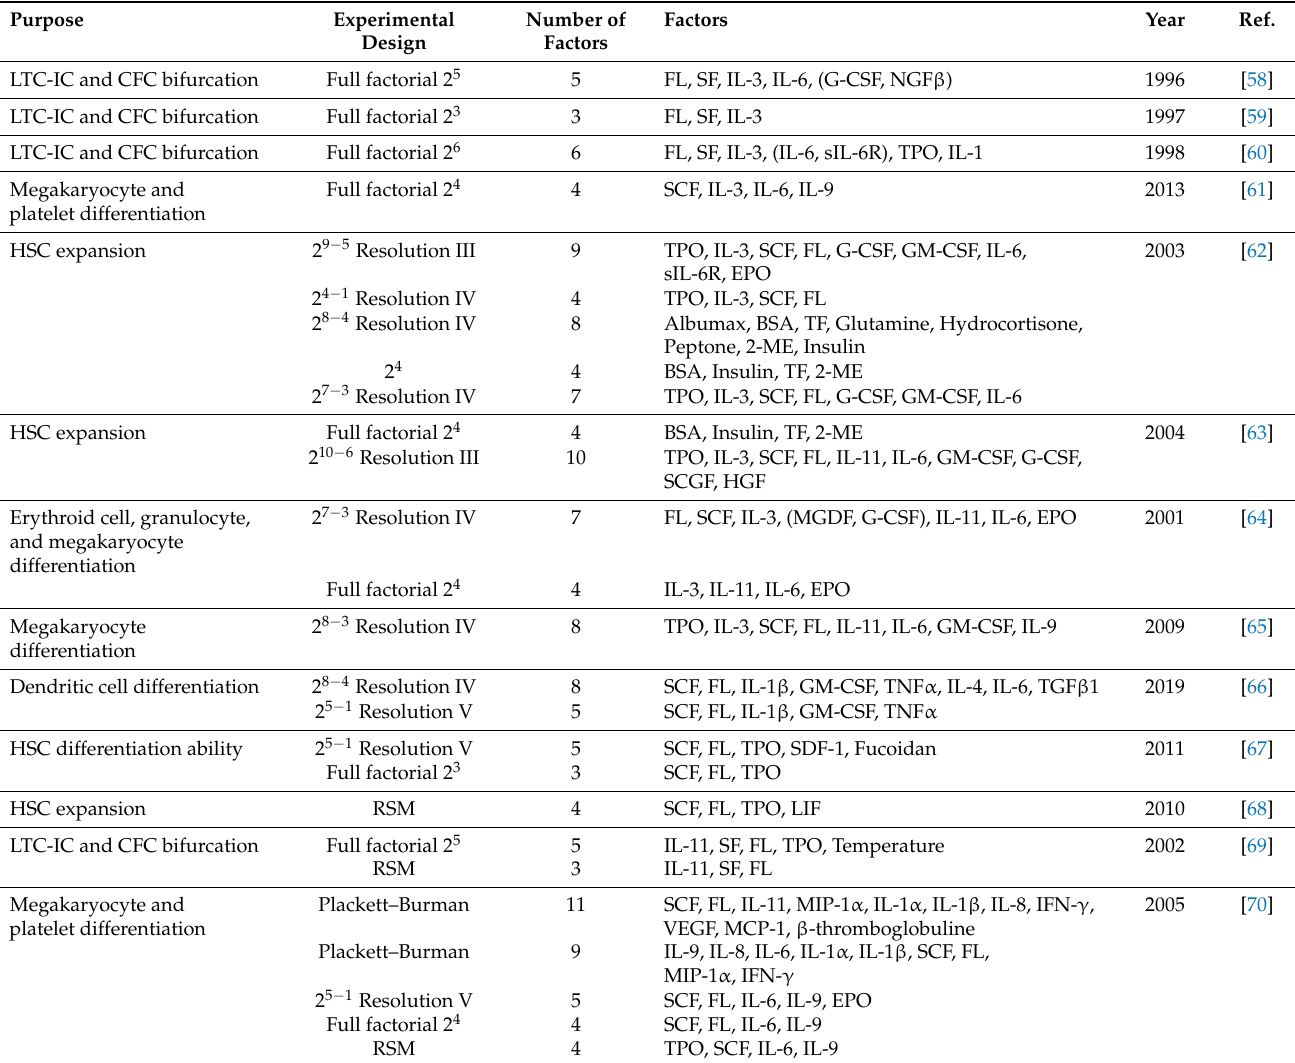
Table 4. DOE studies investigating HSC expansion and